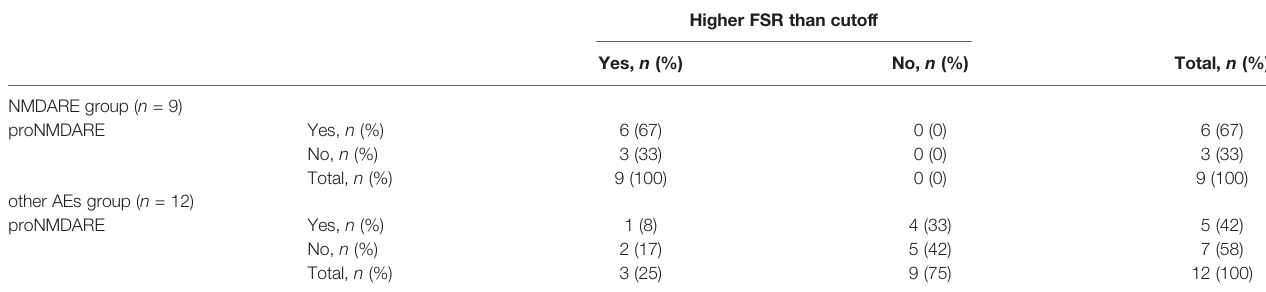
TABLE 2 | Number and frequency of patients who met criteria of probable NMDARE (proNMDARE) and patients whose FSR was higher than our cutoff value. Higher FSR than